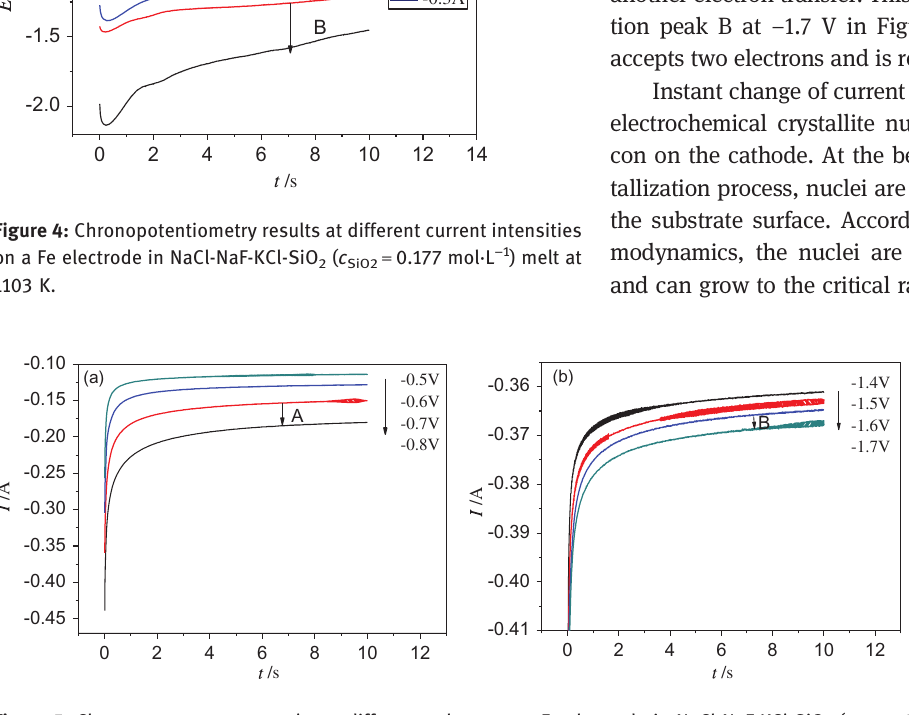
Figure 5: Chronoamperometry results at different voltage on a Fe electrode in NaCl-NaF-KCl-SiO 2 ( c SiO2 = 0.177 mol·L − 1 ) melt at 1,103 K. (a) Peak A, shown in the voltage range of − 0.5 to − 0.8 V, and (b) peak B in the voltage range of − 1.4 to − 1.7